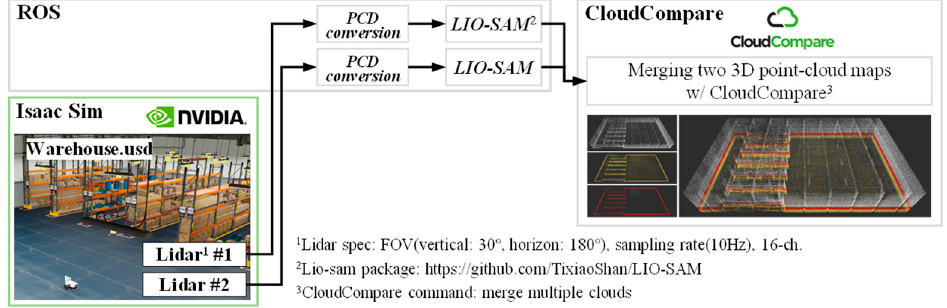
Figure 1. Framework for 3D point-cloud map slicing after SLAM process using LIO-SAM [21,22] with dual scan measurements from two 3D lidar sensors.